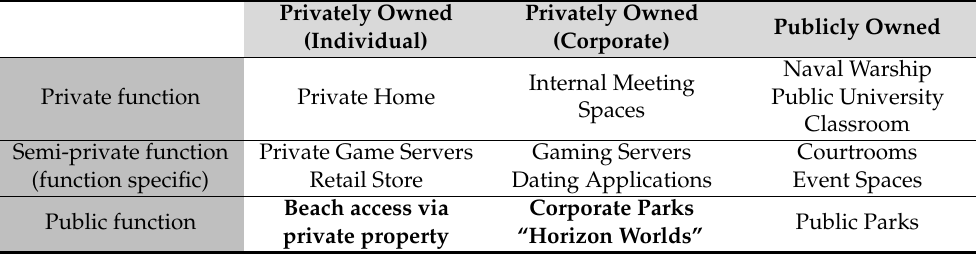
Table 2. A typology of space by function and ownership (privately owned public spaces (POPS) bolded). Privately Owned (Individual) Private